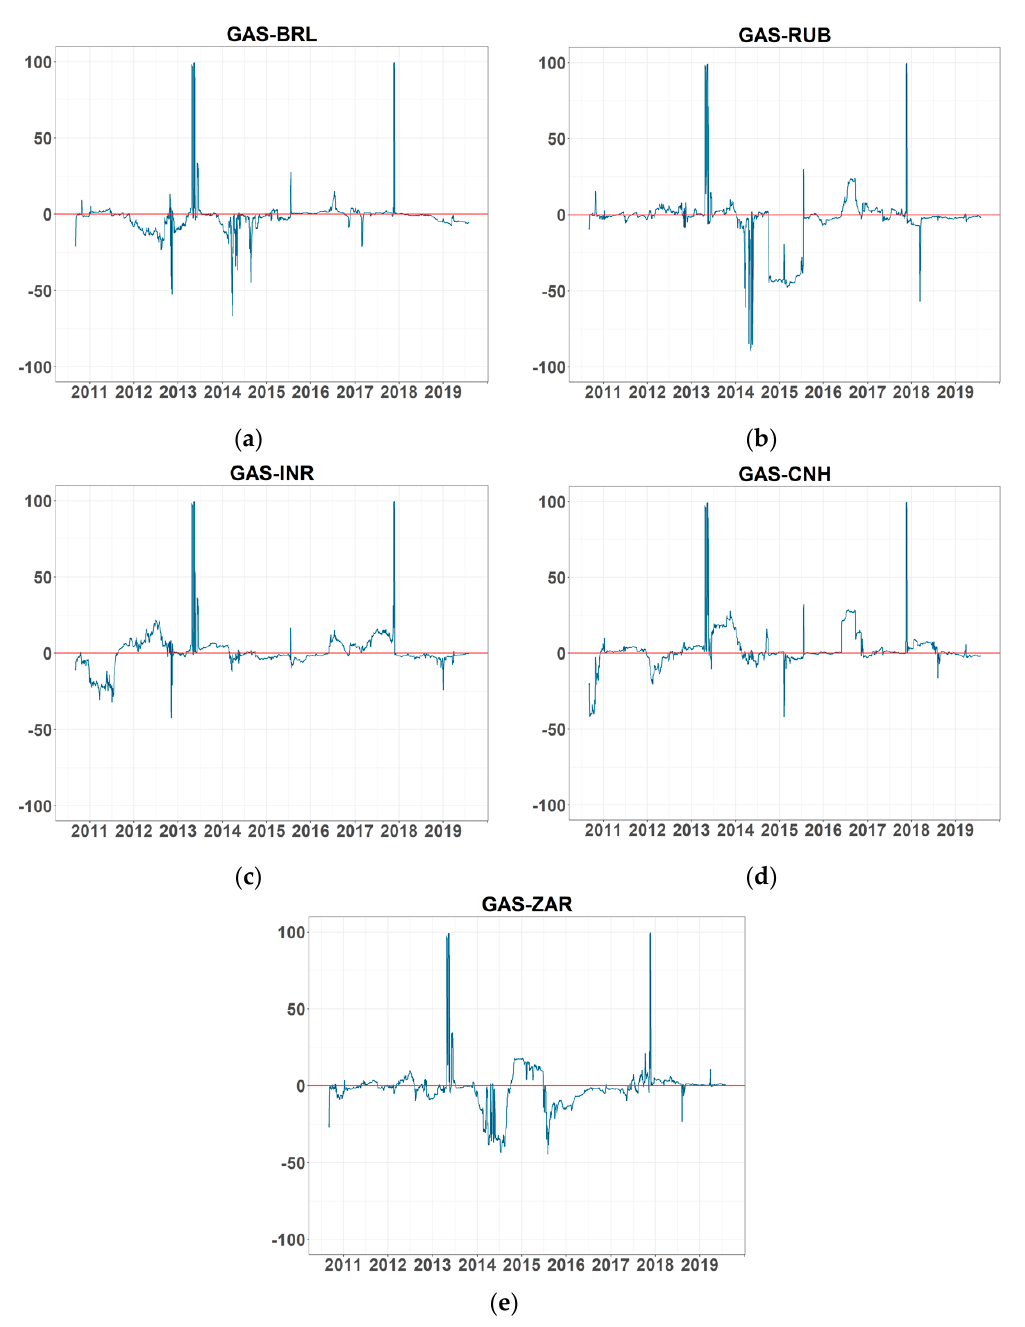
Figure A5. Net pairwise connectedness of volatility. ( a – e ) refer to the net pairwise connectedness between the volatility of GASS and BRL, RUB, INR, CNH, and ZAR, respectively. Note: BRL, RUB, INR, CNH, and ZAR are Brazilian Real, Russian Ruble, Indian Rupee, offshore Chinese Yuan, and South African Rand, respectively. GASF is the Henry Hub natural gas futures price.